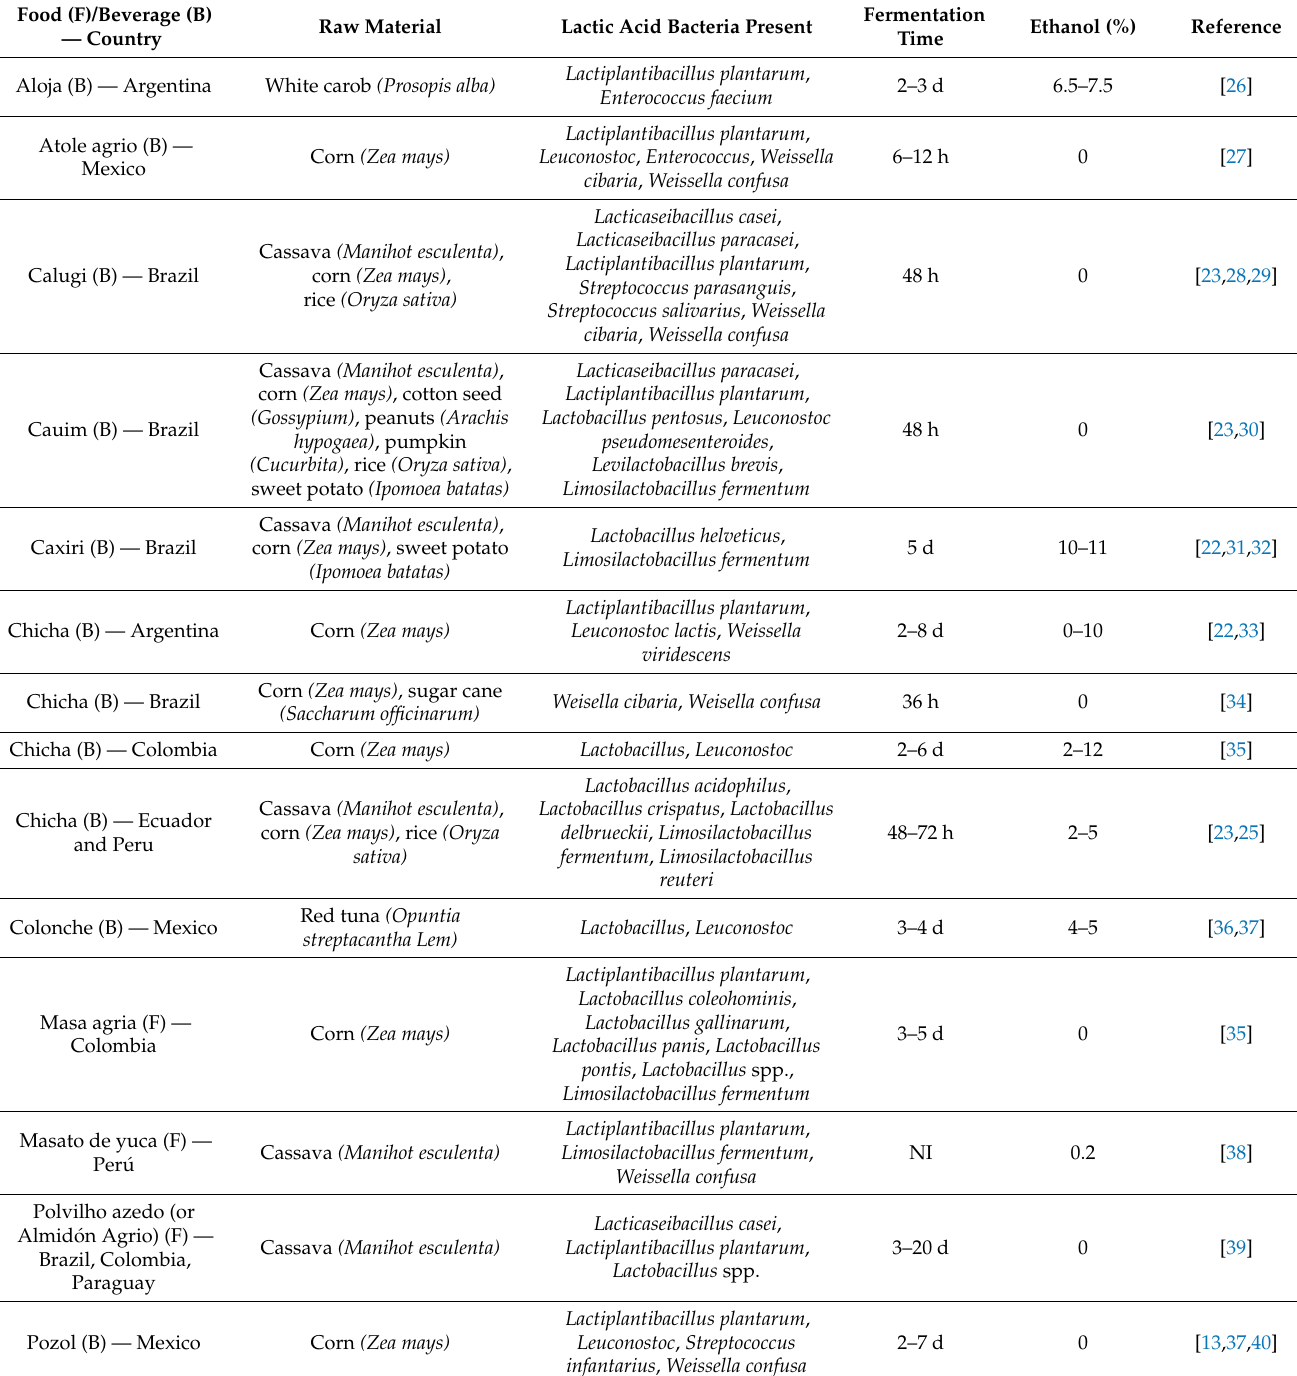
Table 1 summarizes some of the main characteristics of traditional Latin American fer- mented foods and beverages (with and without alcohol) resulting from LAB fermentation. Table 1. Traditional Latin American fermented foods and beverages (with and without alcohol) made using lactic acid